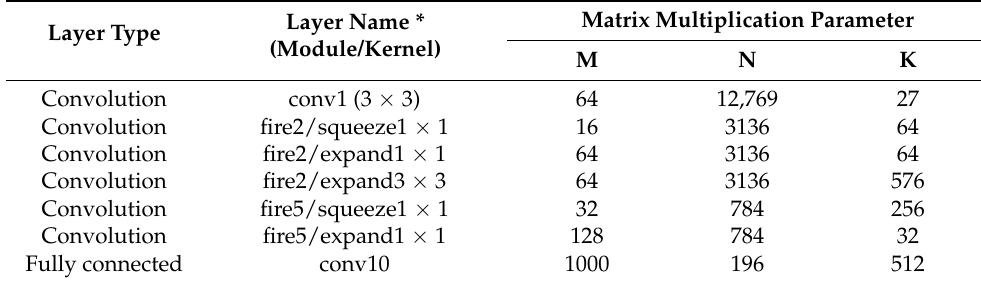
Table 1. Matrix multiplication parameter in SqueezeNet v1.1 with im2col [4,28]. Layer Type